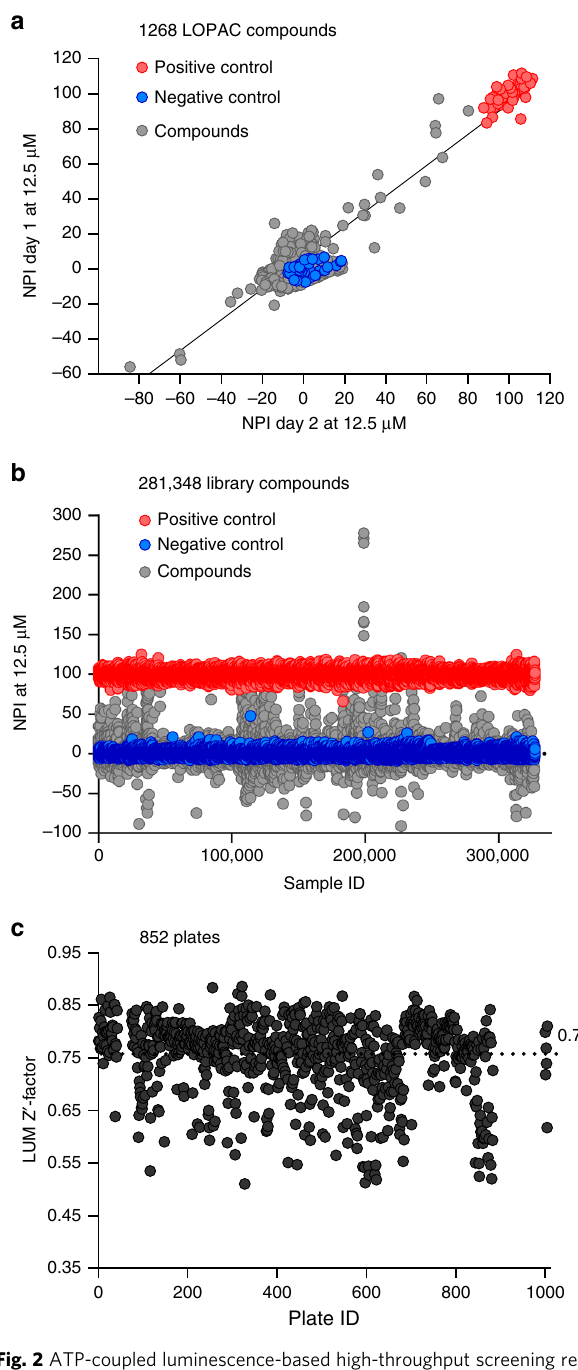
Fig. 2 ATP-coupled luminescence-based high-throughput screening results for h-cGAS. a Sigma-Aldrich LOPAC (library of 1268 pharmacologically active compounds) were tested at 12.5 µ M fi nal concentration for h-cGAS LUM assay. Normalized percent of inhibition (NPI) for each compound tested (gray dots) in two independent days were plotted against each other. Blue dots indicate DMSO negative control and red dots indicate the positive control (no dsDNA). b Scatter plot for the NPI of the 281,348 library compounds tested at 12.5 µ M fi nal compound concentration. Sample ID indicates the unique number assigned for each compound in the library. Gray dots, library compound; blue dots, negative control; red dots, positive control. c Z-prime factor analysis of each library plate. Plate ID indicates the unique number assigned for each library compound